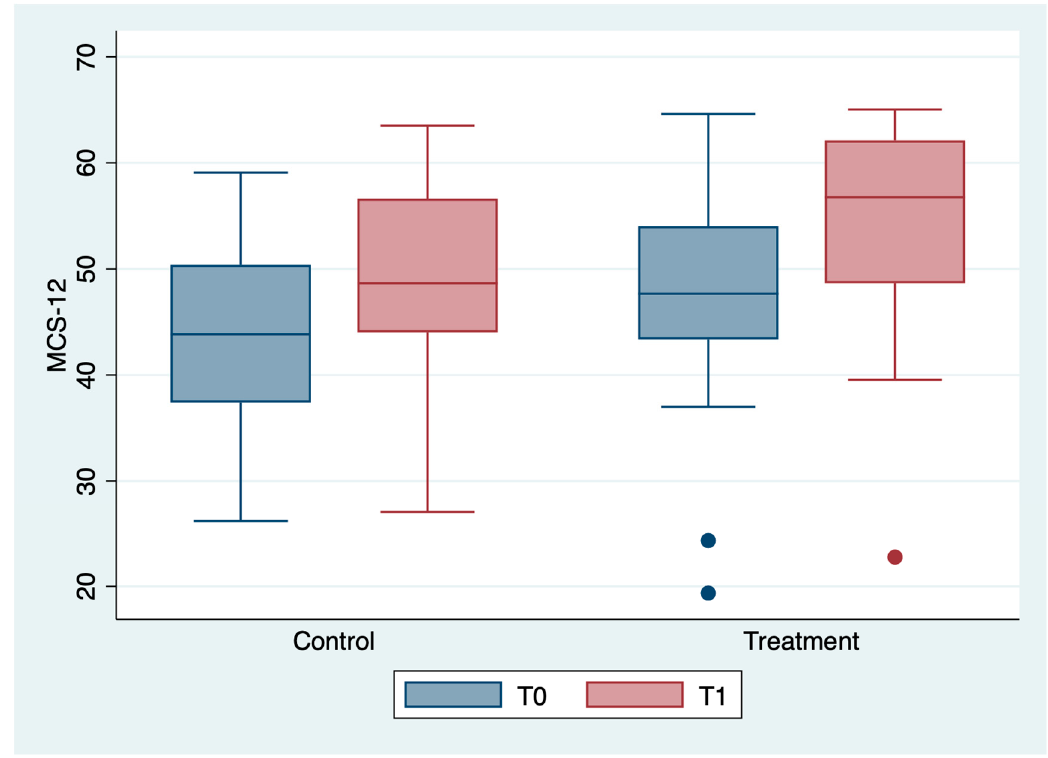
Medicina 2023 , 59 , x FOR PEER REVIEW Figure 3. Box plot of PCS ‐ 12values by detection time and group. Figure 3. Box plot of PCS-12values by detection time and group.